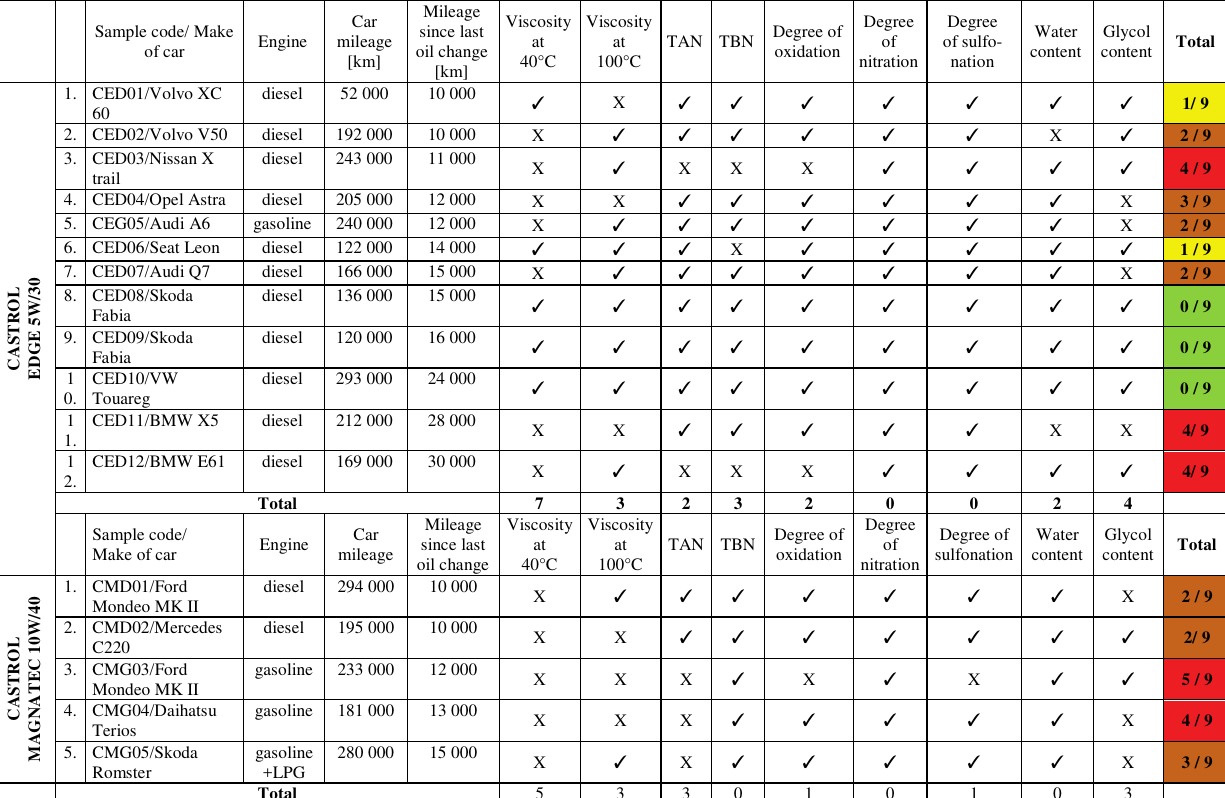
Table 4. Exceedances of the limit values for the analyzed oil parameters: a